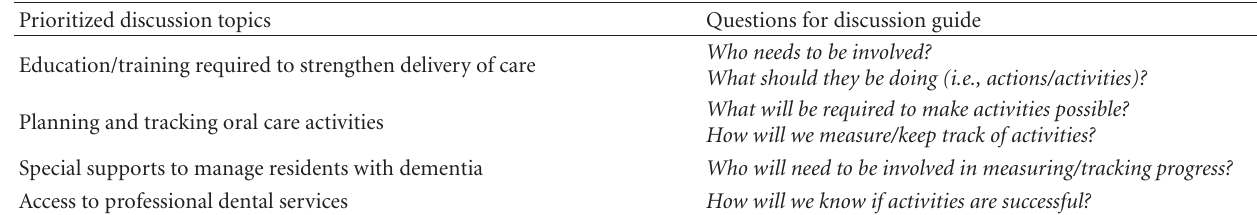
Table 1: Action planning workshop break-out session